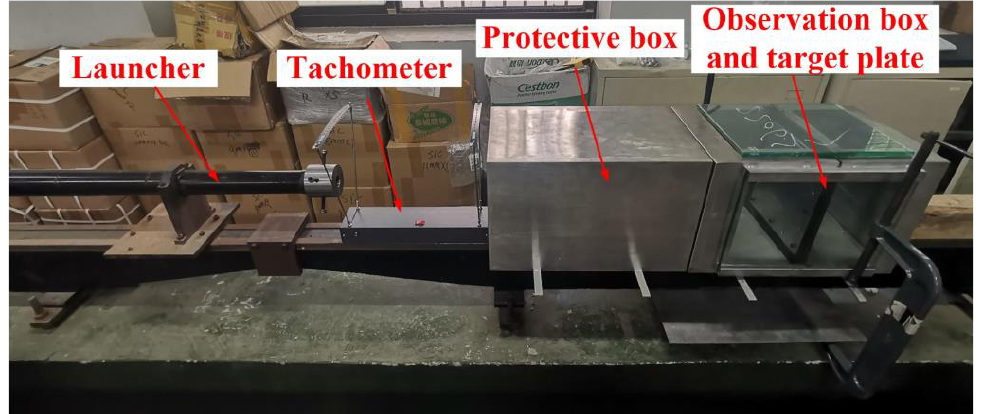
Figure 10. Harpoon impact test layout.